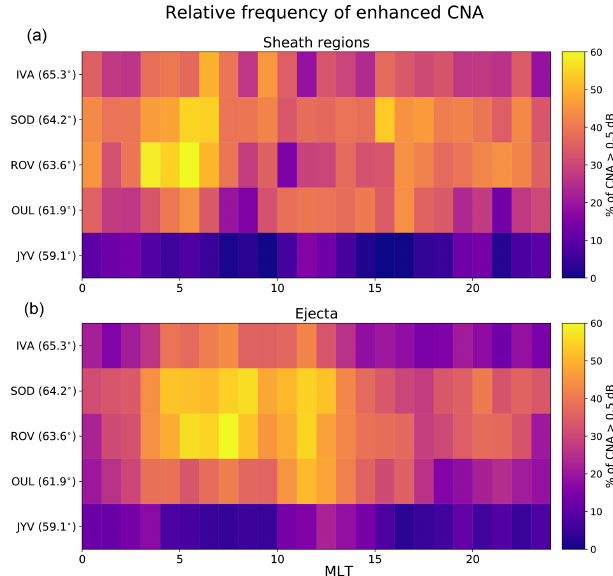
Figure 6. The relative-occurrence frequency of CNA samples with > 0 . 5dB for (a) sheath regions and (b) ejecta as a function of MLT (in 1h bins). Stations are organized according to their MLAT ( ◦ N) that is indicated in parenthesis for each